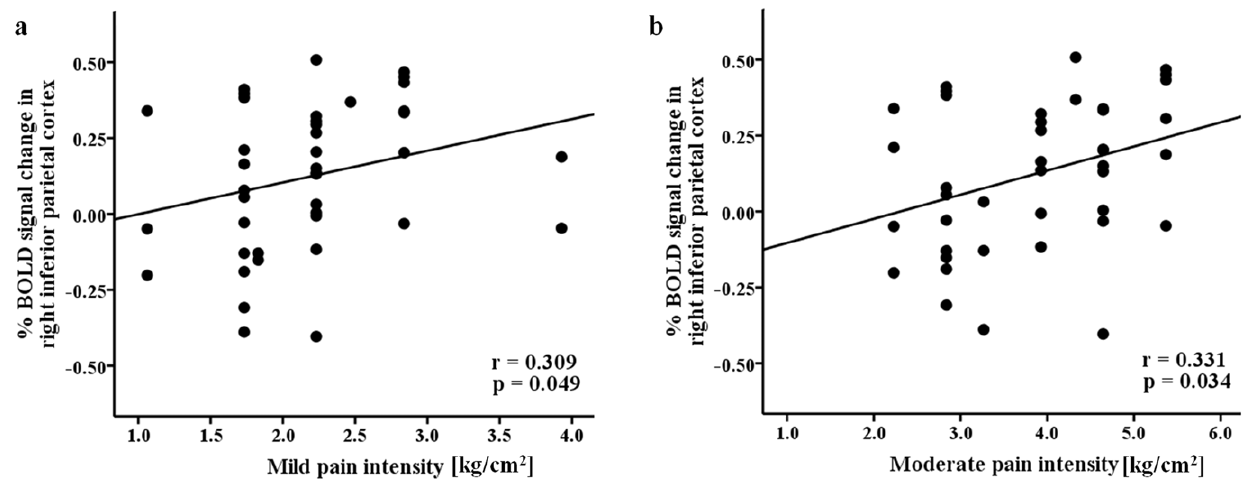
Figure 4. Correlation between BOLD signal change and pressure pain threshold. Percentage BOLD signal change in the inferior parietal cortex showed positive correlation with pressure pain thresholds at (a) mild and (b) moderate pain intensity